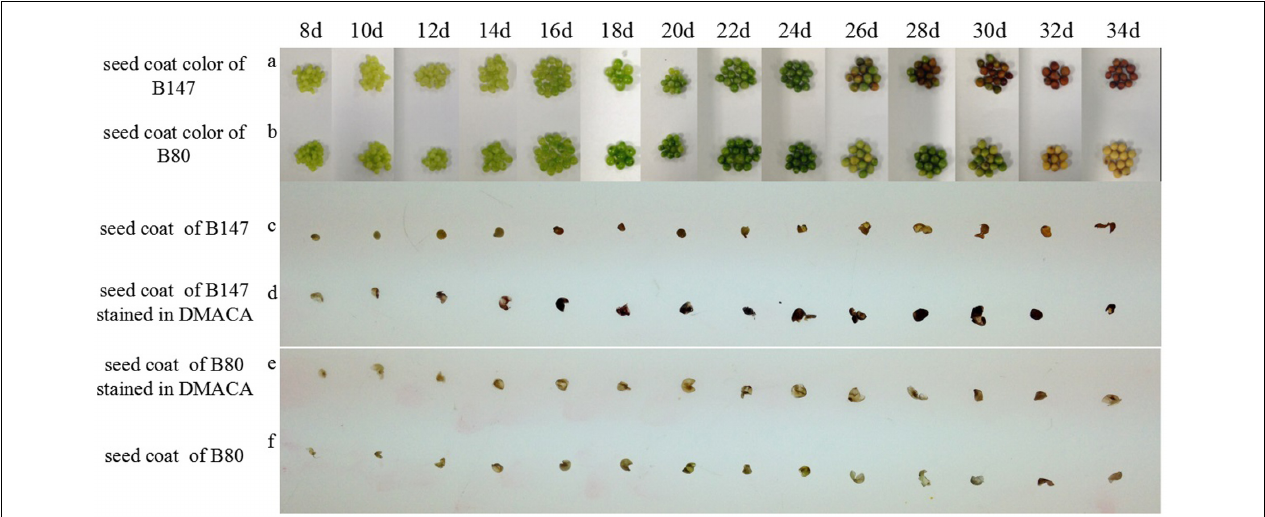
FIGURE 1 | Seed coat color changes during seed development and DMACA staining. (a,b) Seed coat color change during seed development in brown-seeded line B147 and yellow-seeded line B80 Brassica rapa . (c,f) Seed coat color in B147 and B80 during seed ripening period fixed by FAA. (d,e) Seed coat color changes in B147 and B80 after staining in DMACA solution during seed ripening